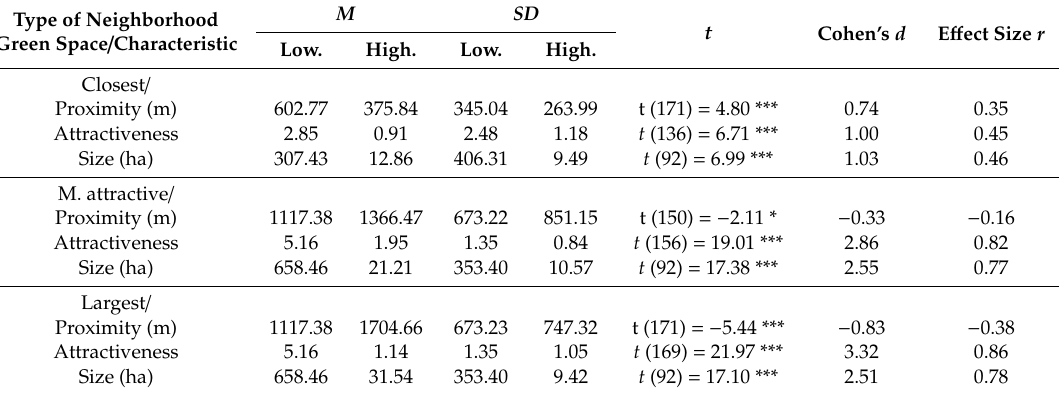
Table 6. Results of independent sample t -test: spatial inequalities in neighbourhood green spaces characteristics between low- and high-deprivation